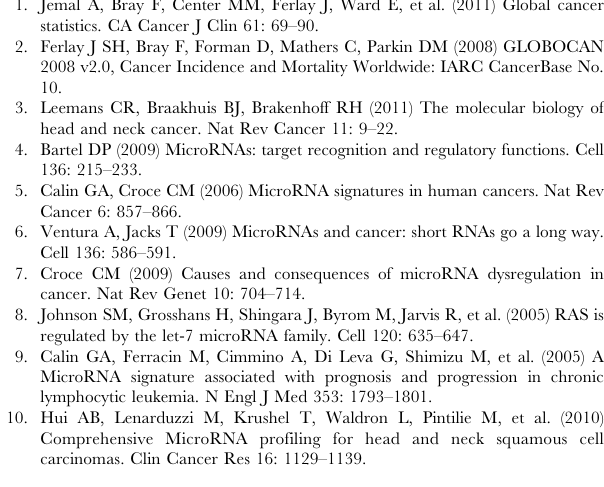
Figure S2 Identification of mRNA targets of miR-193b. (A) Venn diagram showing the tri-modality approach used to identify miR-193b targets. (B) NF1 transcript expression of UTSCC 42a and 8 cells was measured 72 hours post transfection with LNA-193b (40 nM) or LNA-scramble (40 nM). P= ns (not significant). (TIF) Figure S3 Identification of PER2 as a target of miR- 193b. (A) PER2 transcript expression in FaDu cells was measured 72 hours post transfection with LNA-193b (40 nM) or LNA- scramble (40 nM). (B) PER2 transcript expression in UTSCC 42a was measured 72 hours post transfection with LNA-193b (40 nM) or LNA-scramble (40 nM). (C) Western blotting of PER2 in FaDu cells lines was determined 72 hours post transfection, images (above), quantification (below). (D) Relative luciferase activity of FaDu cells after co-transfection with pMIR-PER2 UTR (100 ng) or pMIR-PER2 Mutant (100 ng) vectors with LNA-193b (40 nM) or LNA-scramble (40 nM). *P , 0.05, **P , 0.005, P= ns (not significant). (TIF) Figure S4 MiR-193b targets the RAS signalling pathway in vitro and across HNSCC patient samples. (A) A representative image of miR-193b in situ hybridization of primary HNSCC biopsy samples, arrows indicate tumor cells exhibiting cytoplasmic staining. (B) Representative image of control in situ hybridization of primary HNSCC biopsy samples using a scramble probe. (C) Representative image of miR-193b in situ hybridization of primary breast cancer sample. (D) Representative image of immunohistochemical analysis of p-ERK expression in primary HNSCC biopsy samples (same patient as A), arrows indicate tumors exhibiting nuclear and cytoplasmic staining. (TIF) Table S1 (A) qRT-PCR primer design sequences (B) Cloning primer design